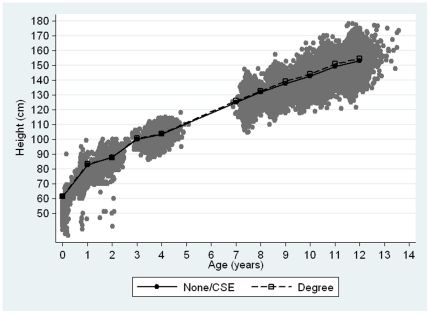
Scatter and mean height (cm) among children whose mothers had none or basic education (CSE) and those whose mothers had a degree*.* There were few children aged 5 or 6 and 13, thus their mean height was calculated jointly with those aged 4 and 12, respectively.